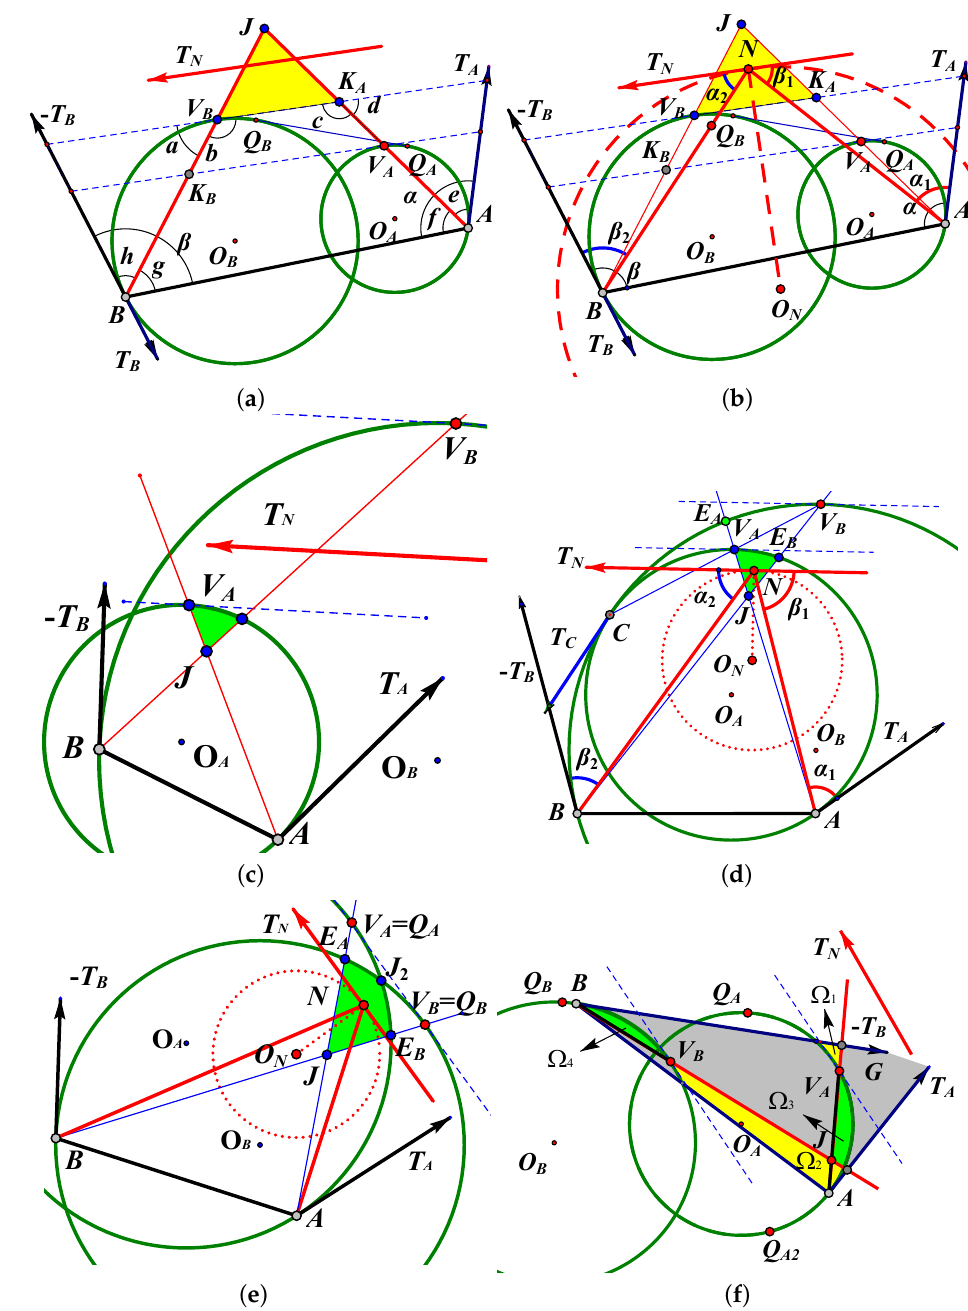
Figure 6. The admissible region for the newly inserted point and inserting new data set { N , T N , O N } . ( a , b ): J is outside both circles; ( c – e ) J is inside both circles; ( f ): J is inside one circle and outside the other